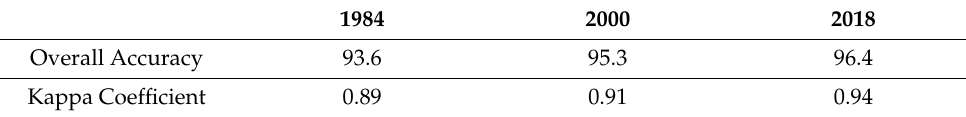
Table 3. Overall accuracy and kappa coefficient in three classified images.